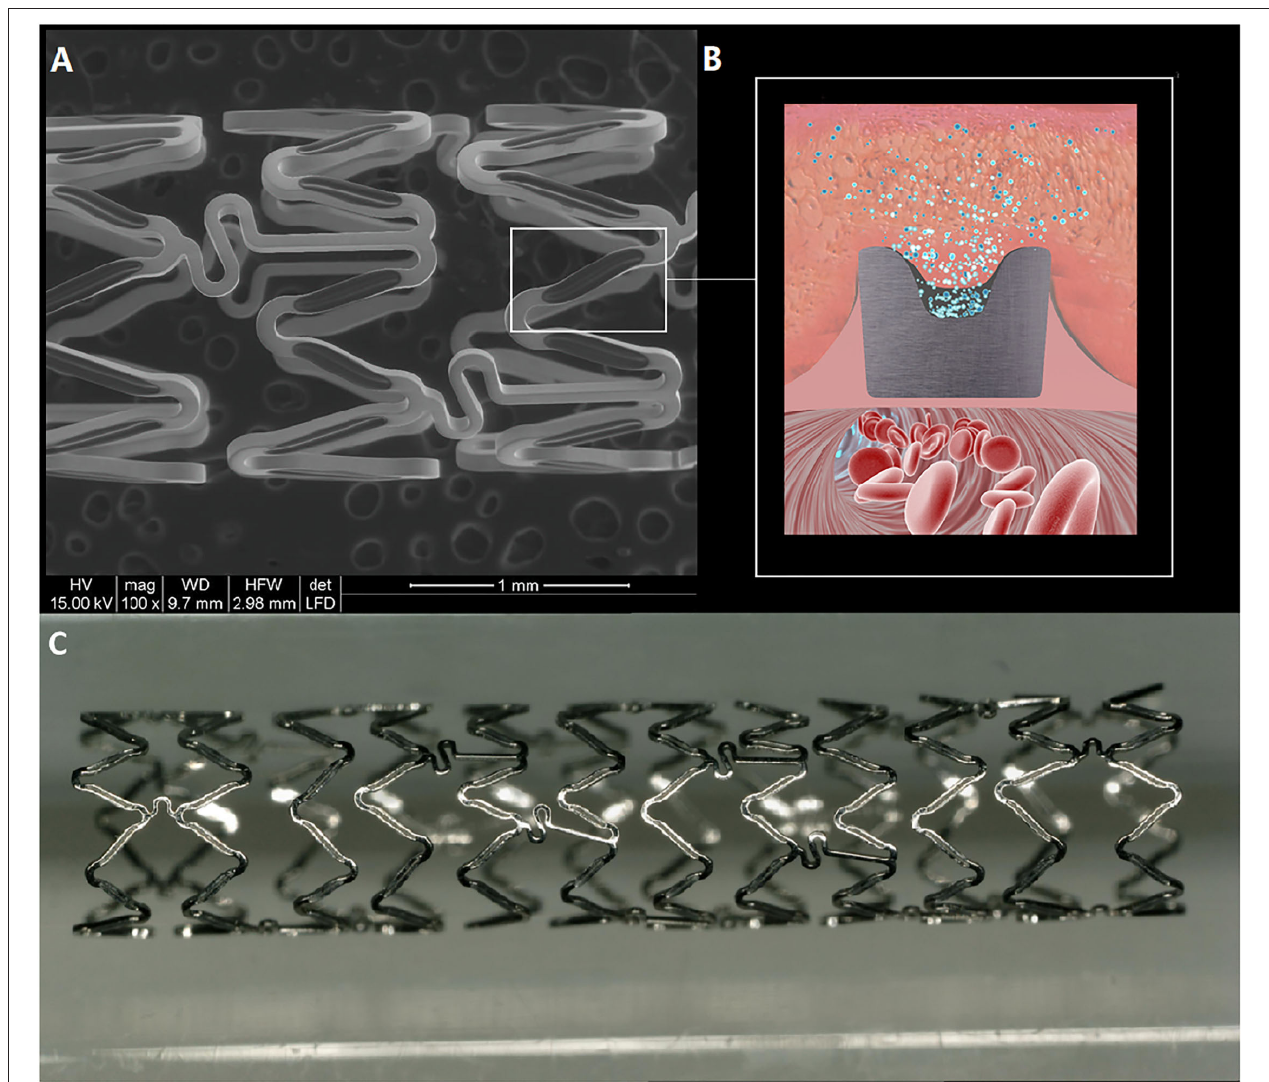
FIGURE 1 | The Firehorus stent design. (A) The Firehorus stent is made of L605 cobalt chromium alloy; (B) Abluminal surface with recessed grooves containing D, L -polylactic acid biodegradable polymer, which provides controlled rapamycin (sirolimus) release; and (C) The Firehorus